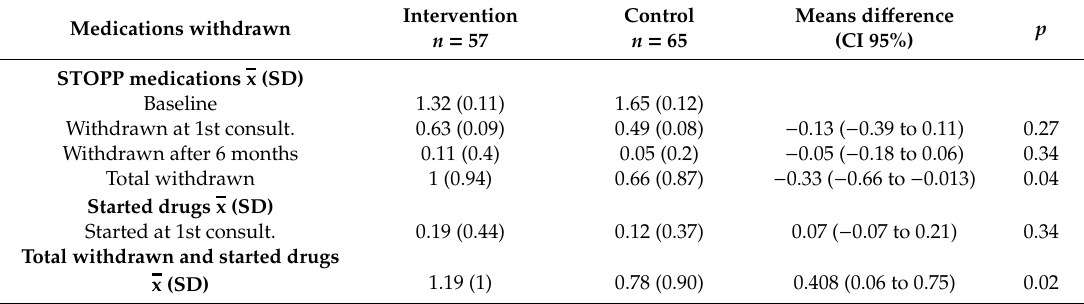
Table 4. E ff ect of the intervention on the number of inappropriate medications withdrawn at the first consultation and after six